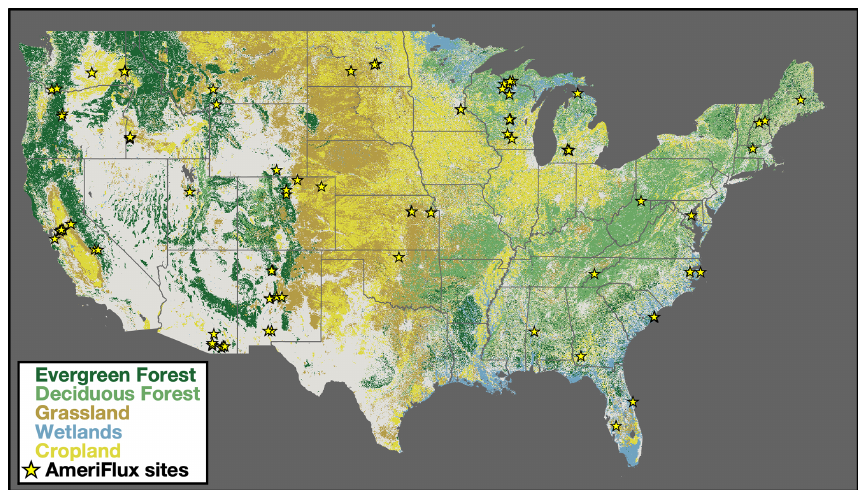
Figure 1. Dominant land cover over the conterminous United States (CONUS). Colors show the dominant land cover over CONUS. Classifi- cation is based on the 2019 USDA (United States Department of Agriculture) CropScape database (USDA, 2018). Forests are shown in green croplands in yellow, and wetlands are in blue. Location of 102 AmeriFlux sites used in this study are shown as yellow stars. See Table S1 for a list of all